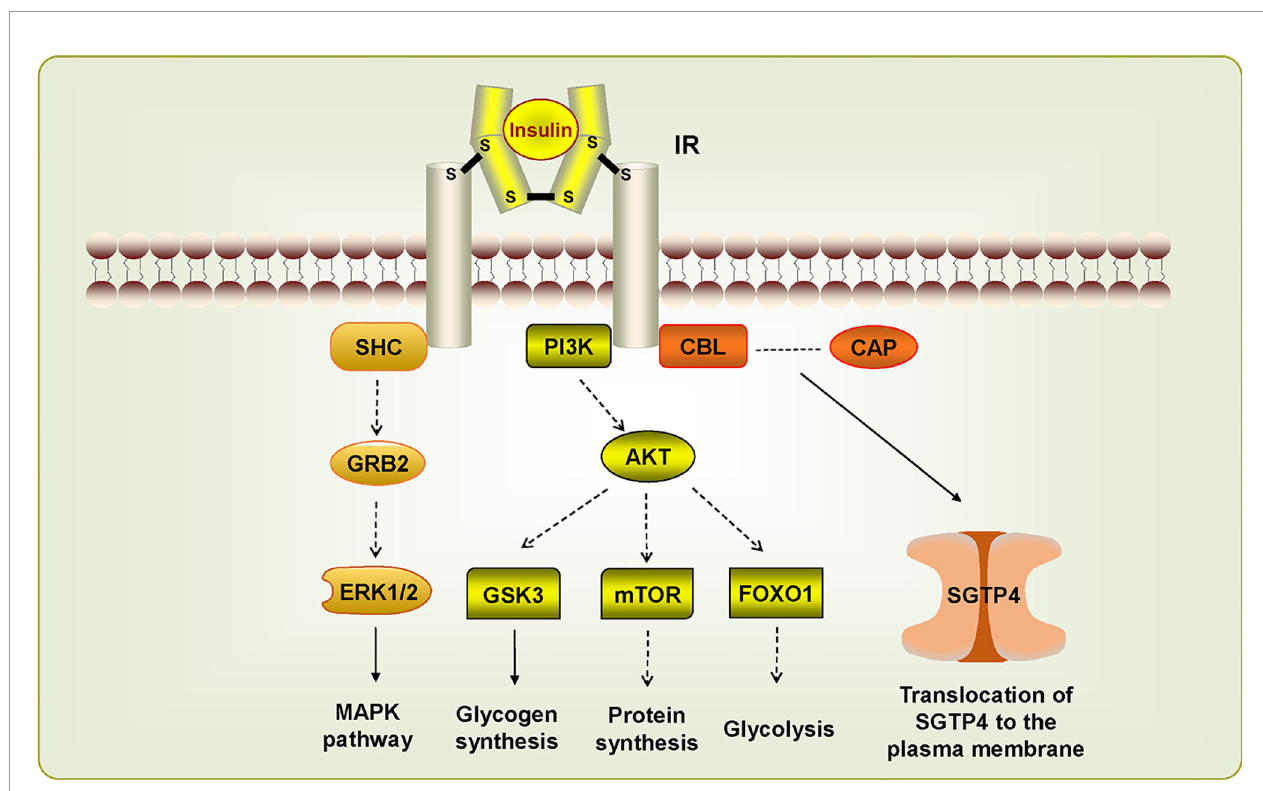
FIGURE 3 | Insulin receptor signaling pathways in Schistosoma japonicum . The dotted line suggests this pathway has not (yet) been demonstrated in S. japonicum . The IR signaling pathways are activated by insulin, which stimulate downstream pathways. SHC can bind IR to induce MAPK pathway. PIK3/AKT pathway is associated with glycogen synthesis, protein synthesis, and glycolysis. CBL/CAP pathway is involved in the translocation of SGTP4 to the plasma